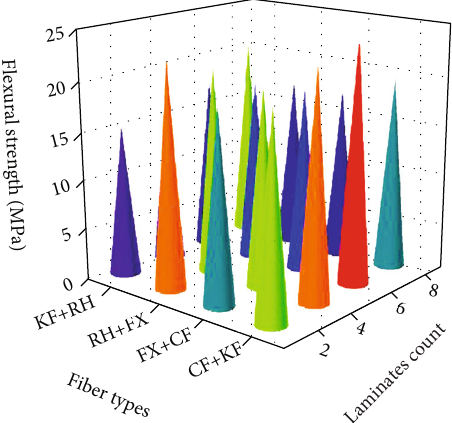
Figure 7: Flexural strength: 3D plot of fi ber types and laminate count.